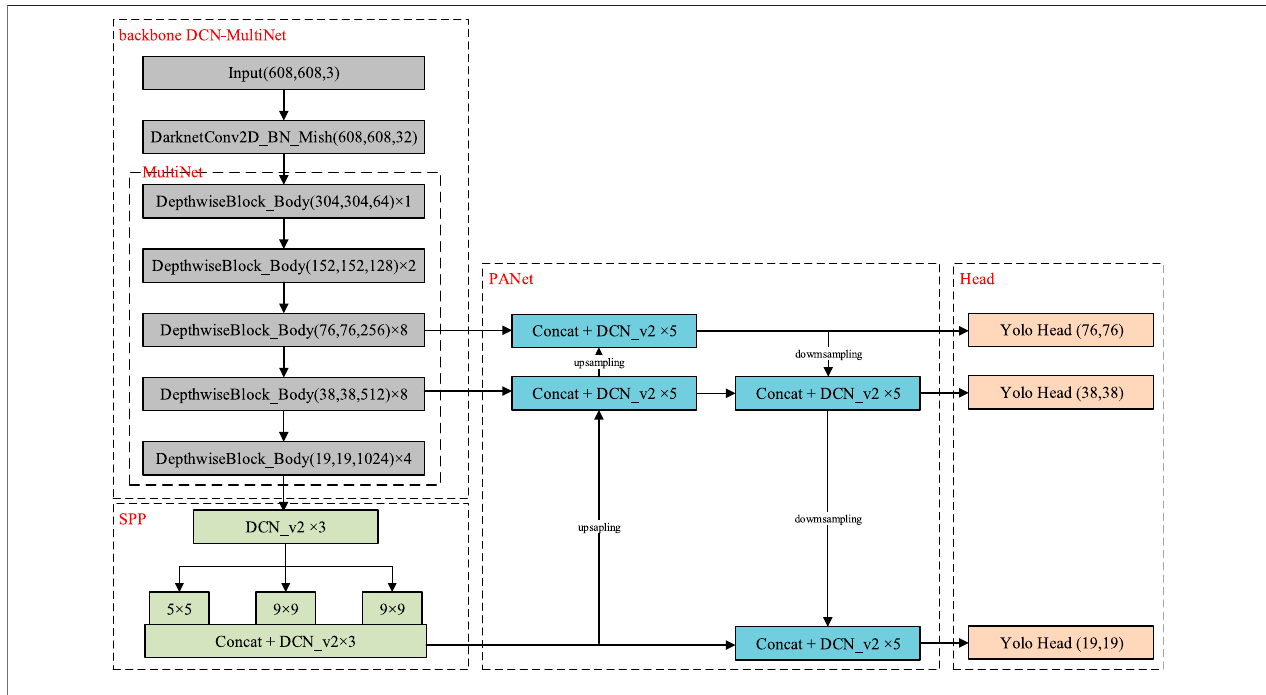
FIGURE 2 | Network architecture of